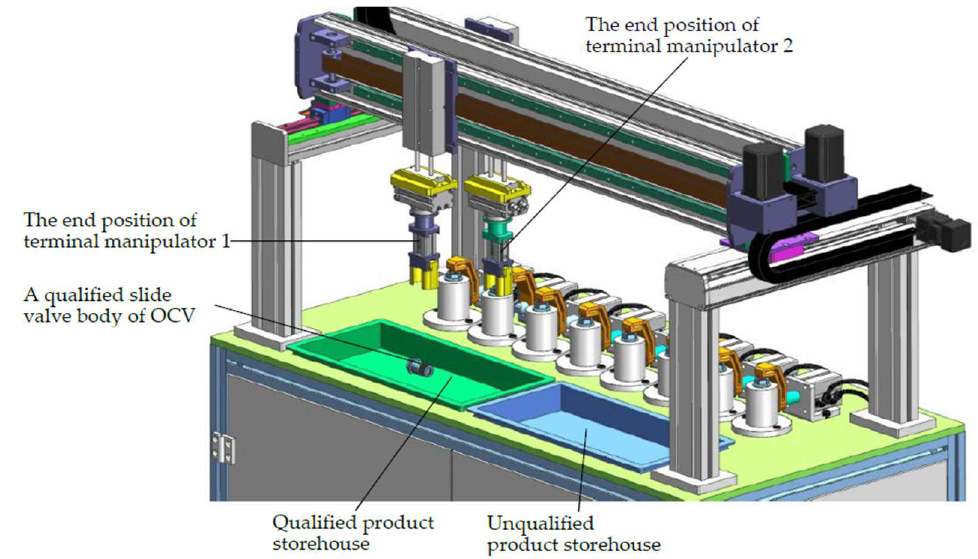
Figure 11. Sketch map of sorting action 2.